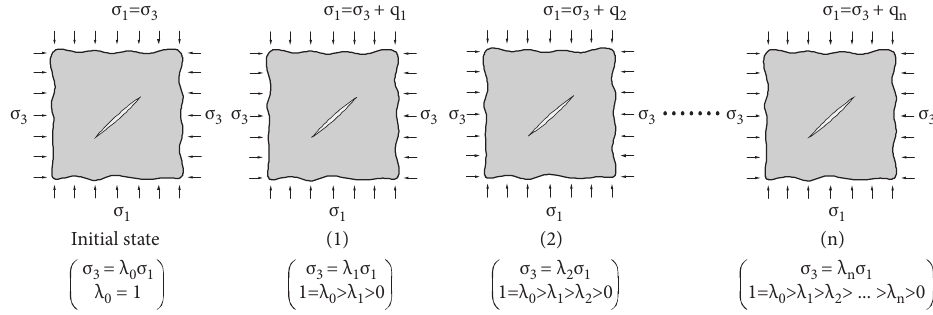
Figure 6: Variation of confining pressure coefficient with loading